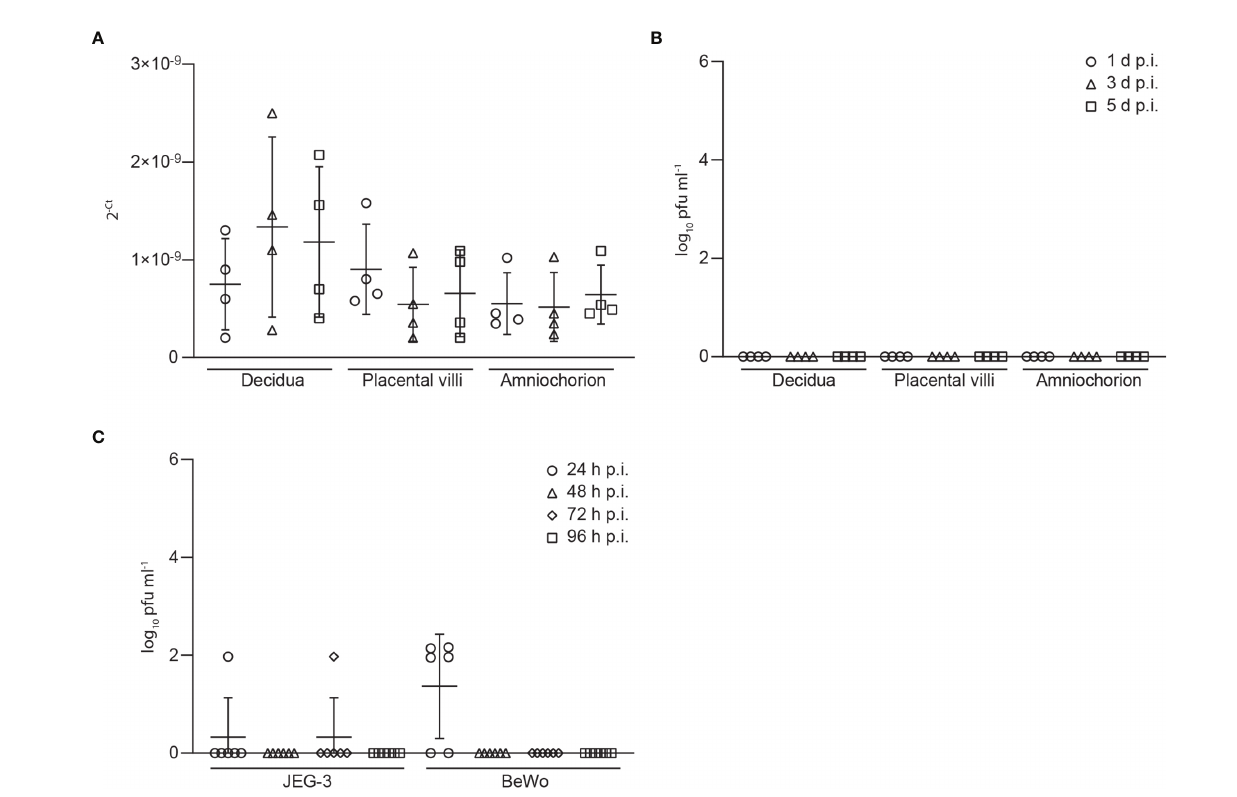
FIGURE 3 | Low levels of viral RNA and viral load in explant supernatants of SARS-CoV-2 inoculated explants. (A) Levels of viral RNA, as indicated by Ct-values, was measured by PCR in explant supernatants of SARS-CoV-2 inoculated explants. (B) Detection of infectious virus, derived from SARS-CoV-2 plaque test using supernatants of SARS-CoV-2 infected placental explants harvested at 1, 3 and 5 days post infection (d.p.i.). Data are provided as plaque forming units (pfu). (C) Infectious virus assessment in supernatants of JEG-3 and BeWo placental cells at 24, 48, 72 and 96 hours post infection (h.p.i.). Lines in scatter plots show median and standard